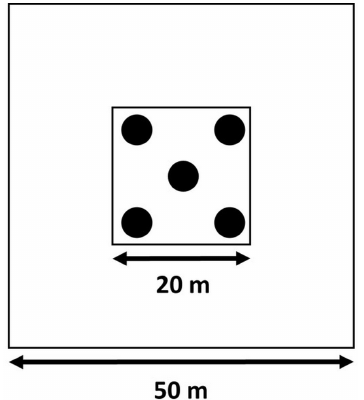
Figure 2. Soil sampling design according to a five-on-dice pattern, performed in the central 20 × 20m area within each of the 50 × 50m